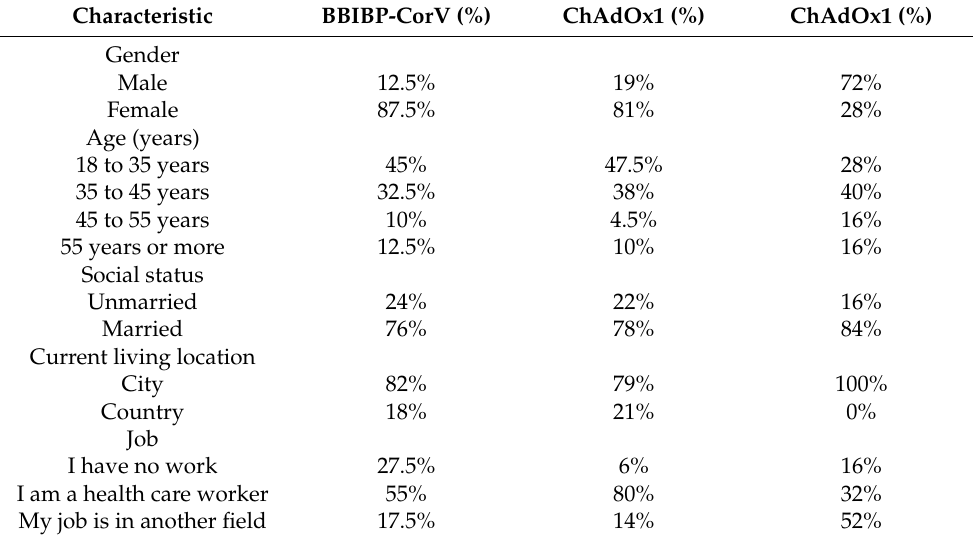
Table 1. Characteristics of the